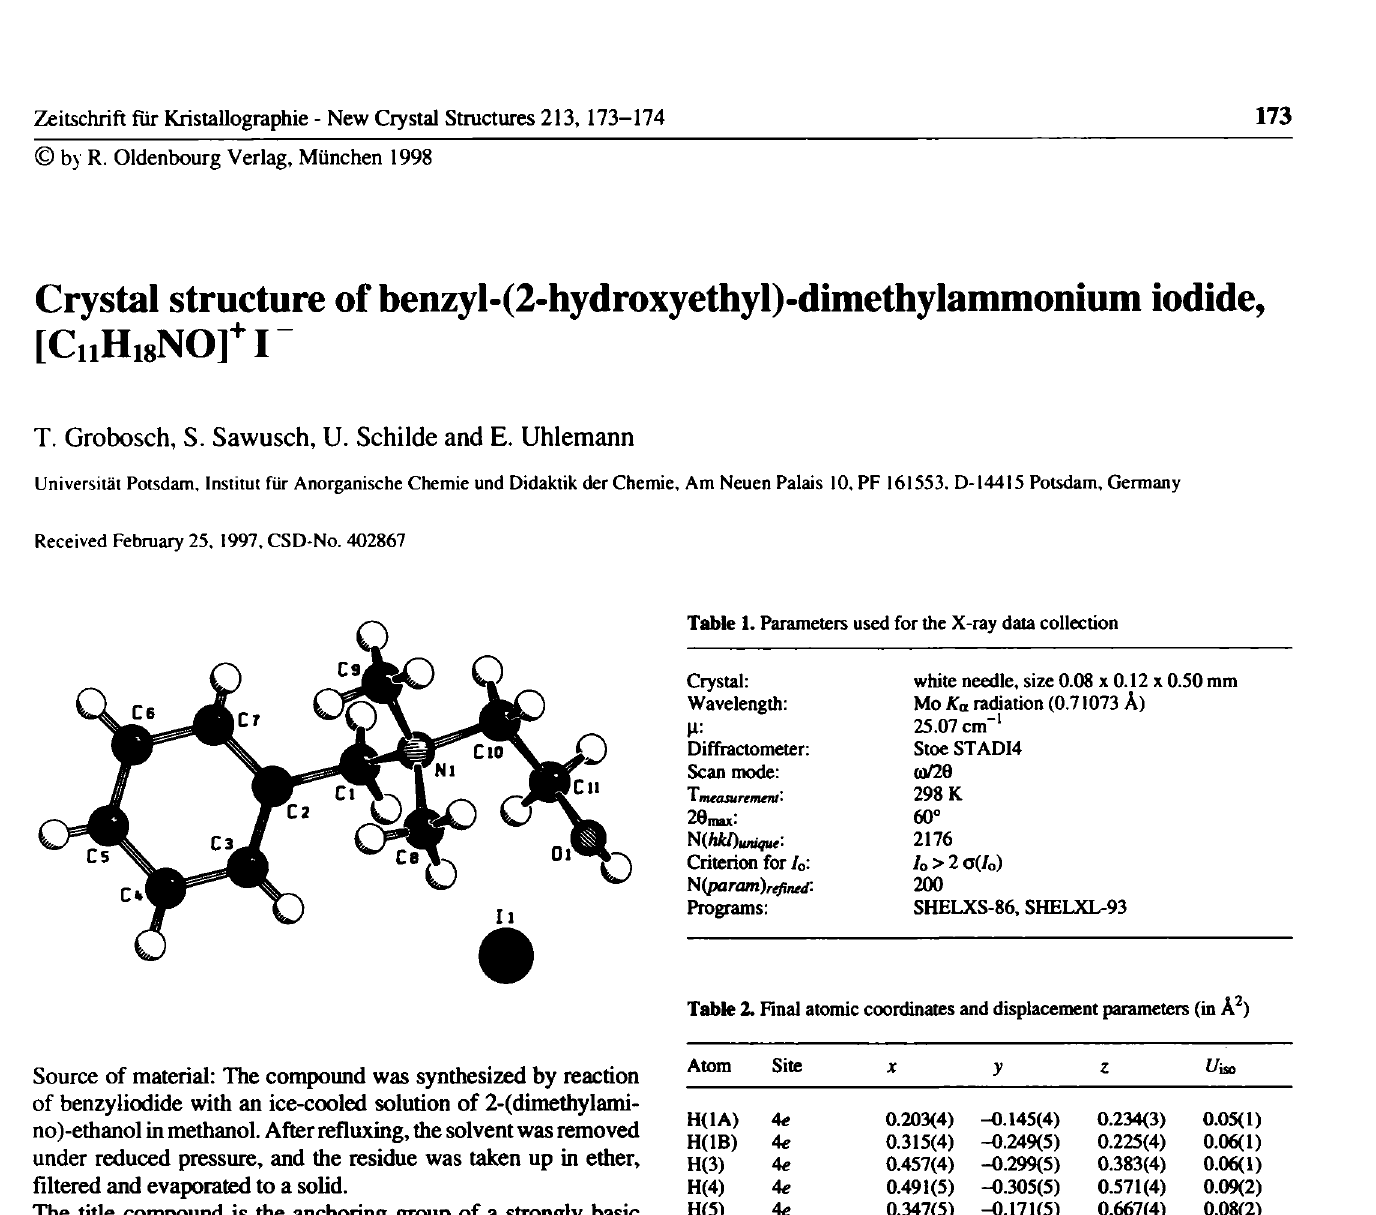
Table 2. Fmal atomic coordinates and displacement parameters (in Â^)